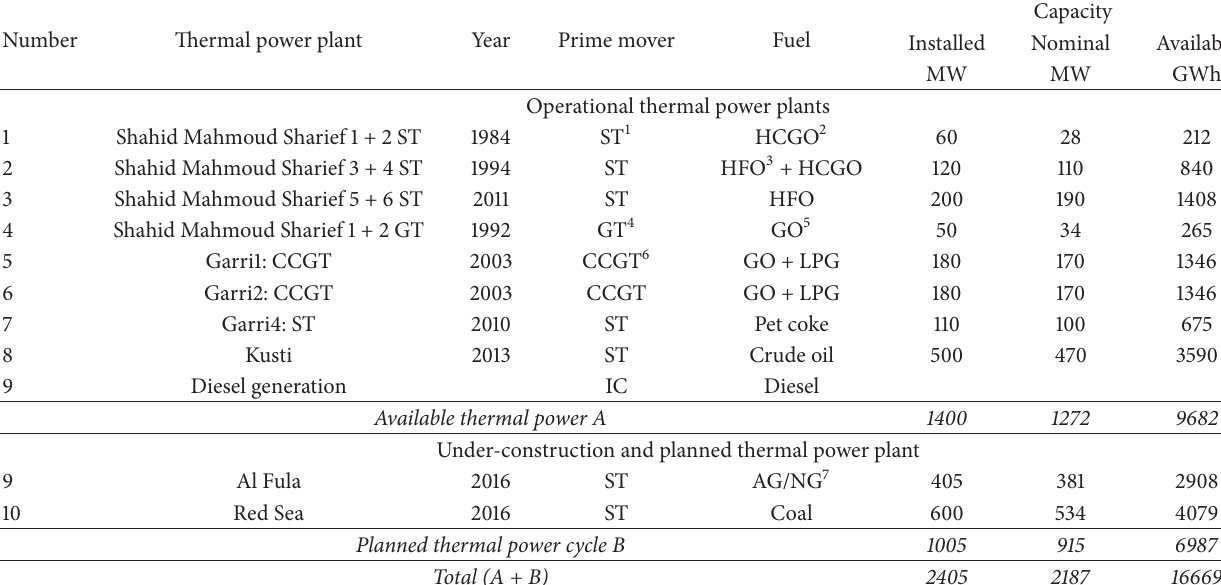
Table 3: Thermal power